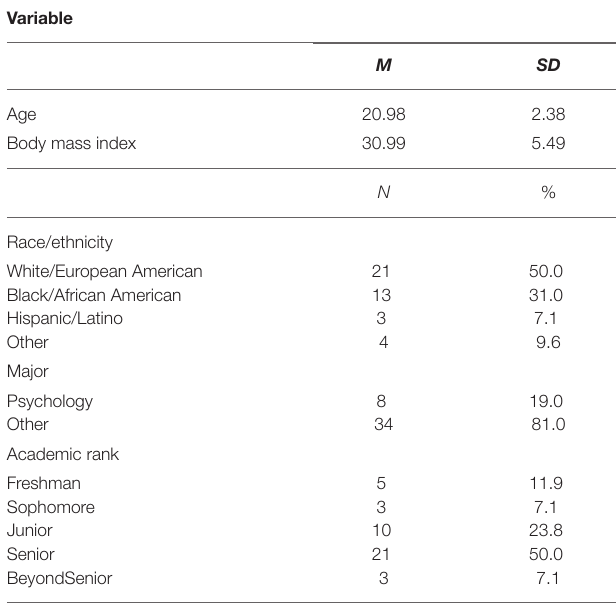
TABLE 1 | Demographic characteristics of participants at baseline (analyzed completers